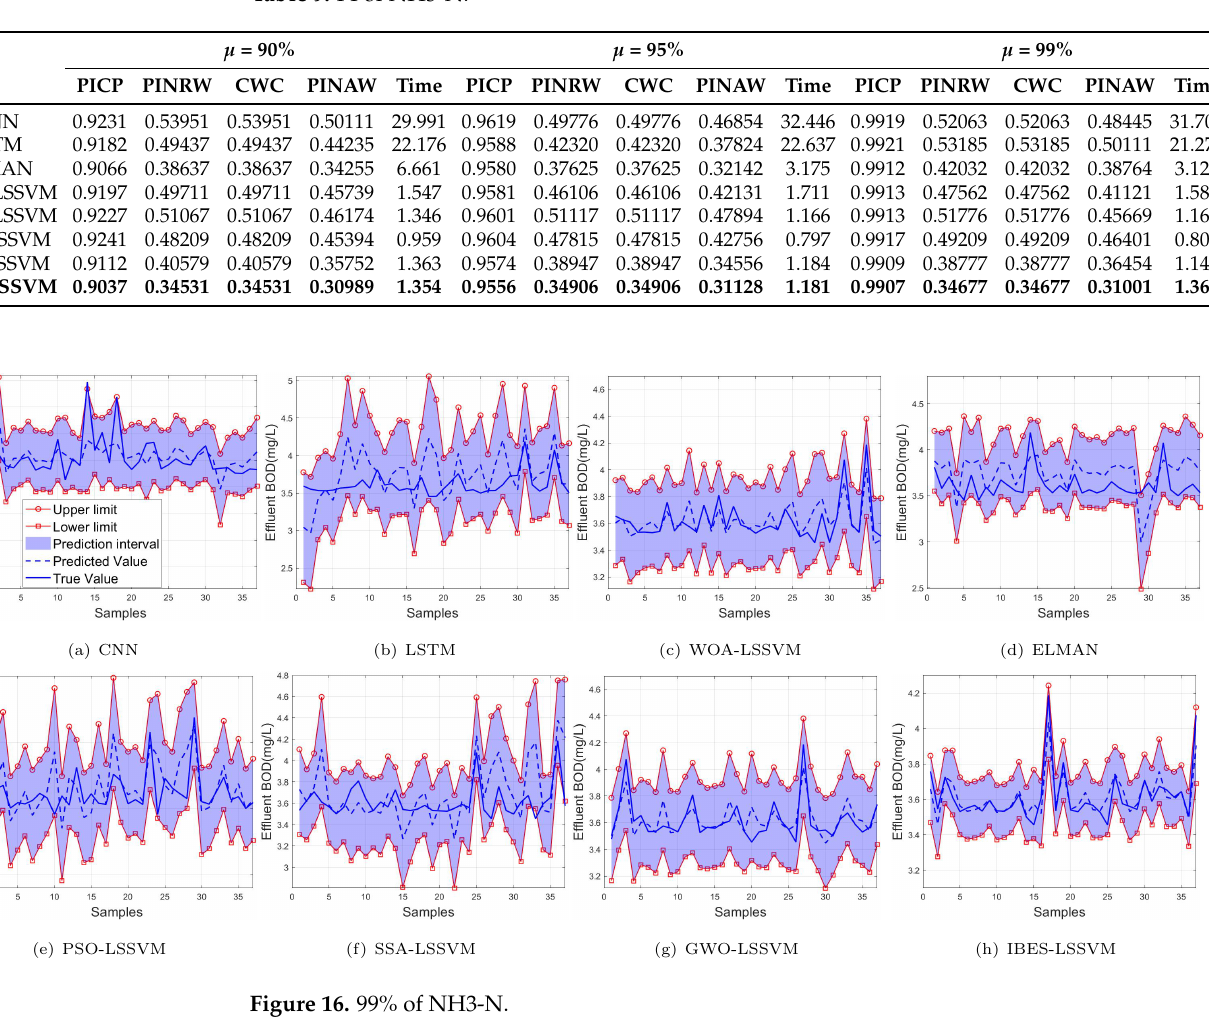
Table 9. PI of NH3-N.